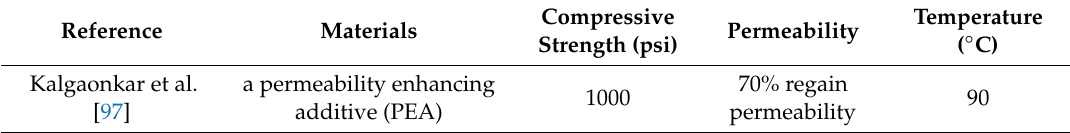
Table 17. Permeability enhancing additive (PEA) method to consolidate sand